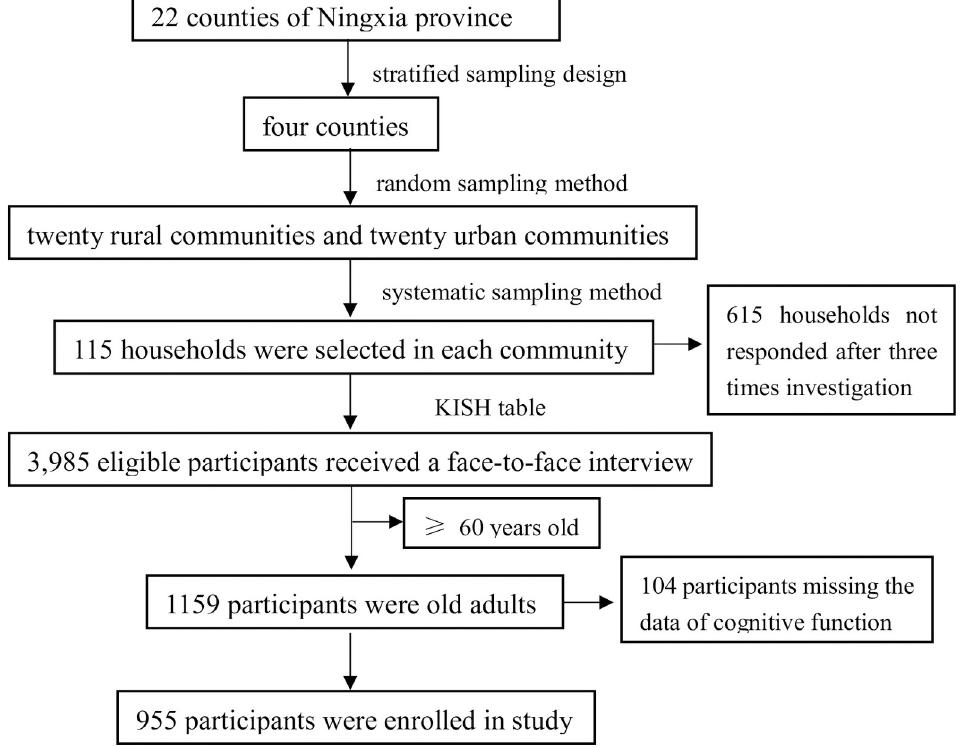
Fig 1. Participant screen